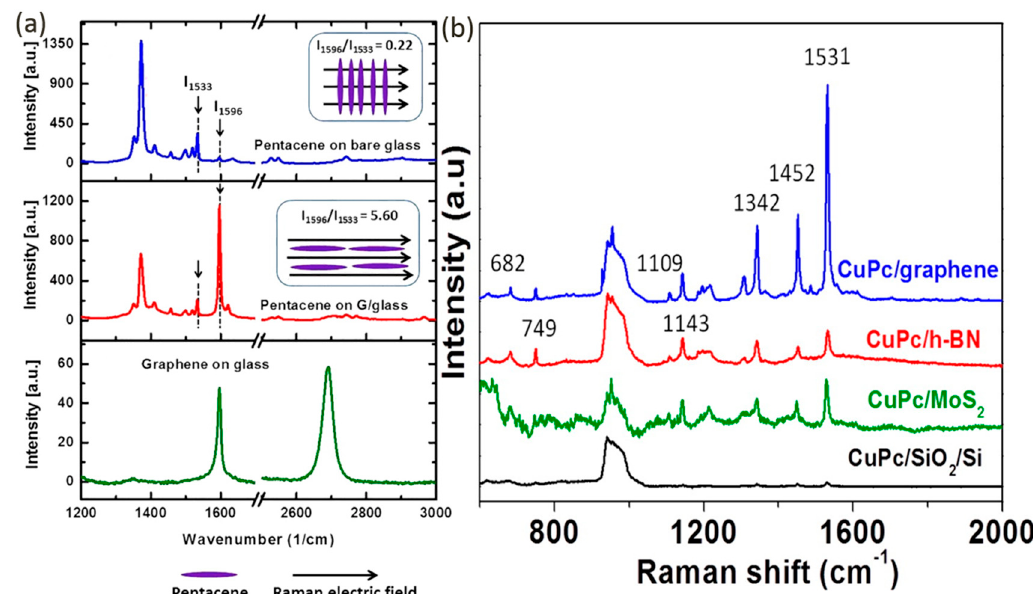
Figure 5. ( a ) Raman spectra from pentacene on glass without/with monolayer G, and from G on glass. ( λ = 532 nm; 3.0 mW). ( b ) Raman spectra from 2 Å thick CuPc on G (blue line), on h -BN (red line), on MoS 2 (green line), and on the blank SiO 2 /Si substrate (black line). Panel a reprinted with permission from [36], copyright 2015 American Chemical Society. Panel b reprinted with permission from [55], copyright 2015 American Chemical Society.